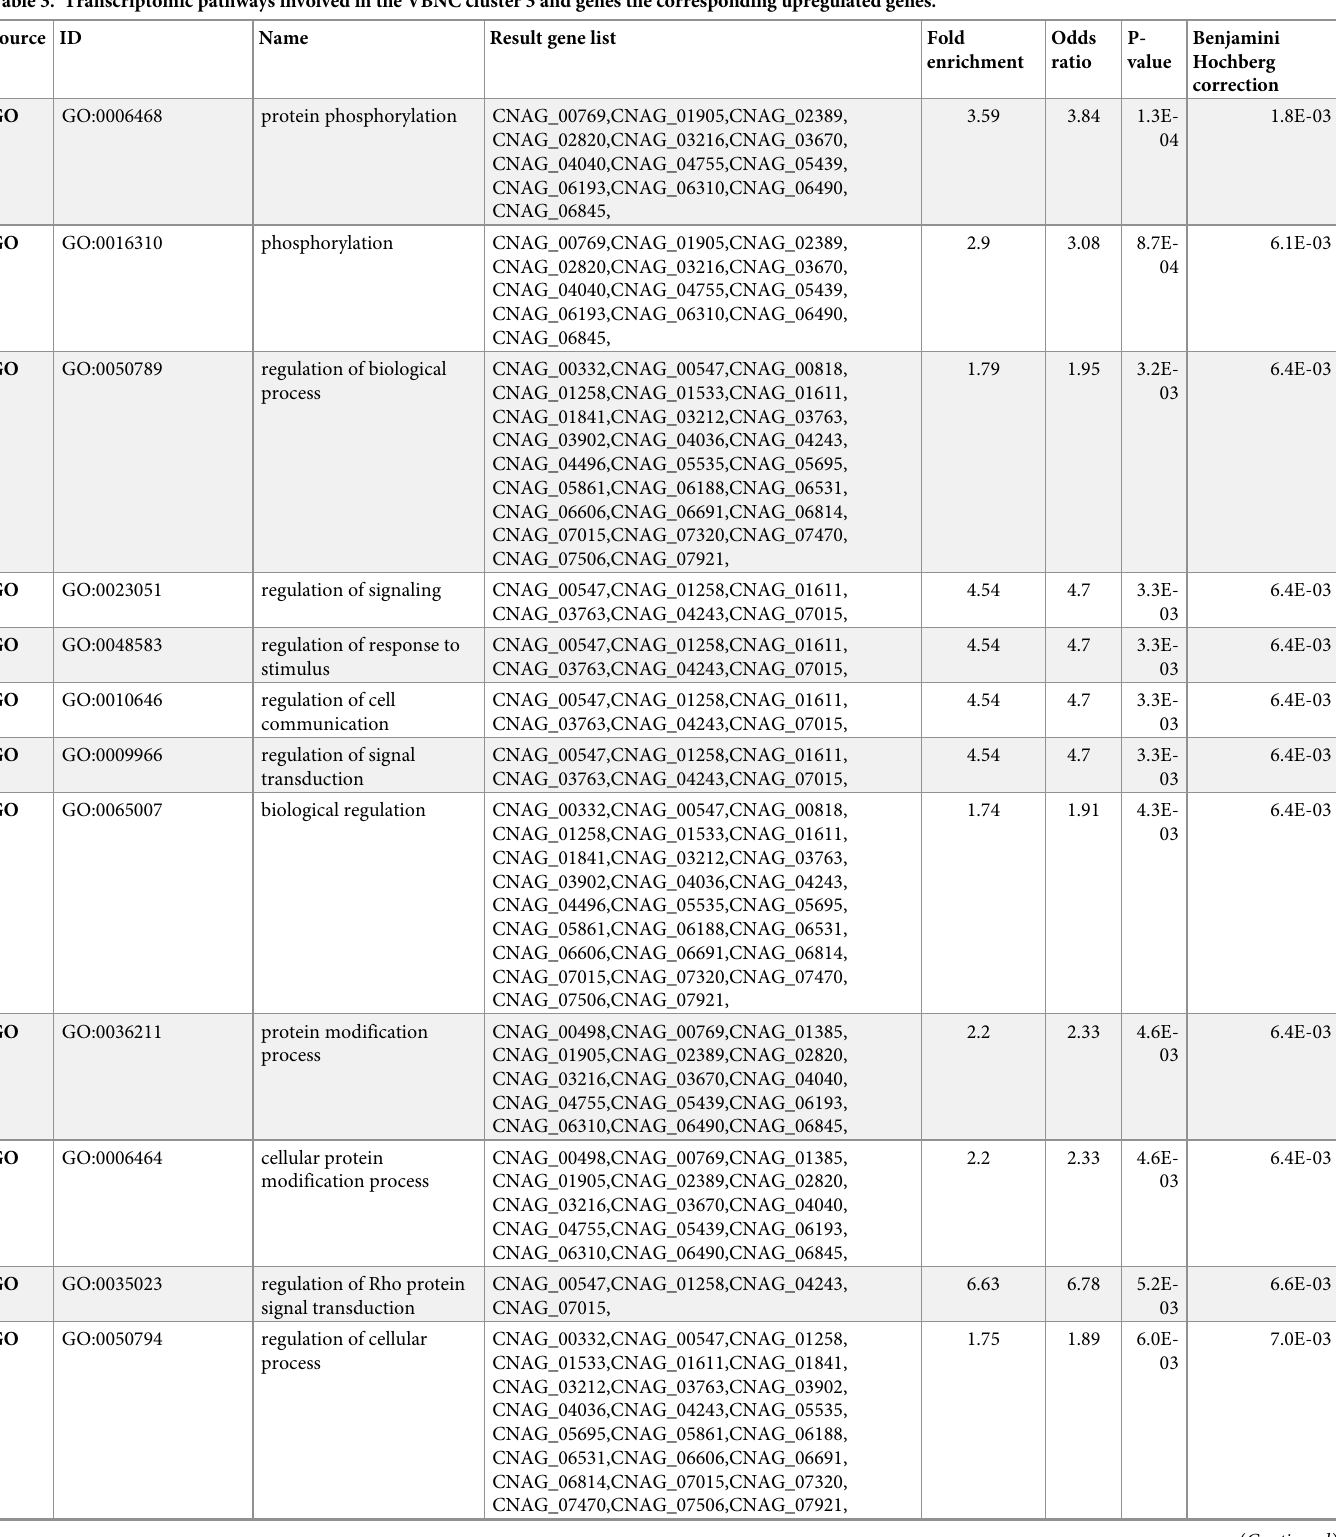
Table 3. Transcriptomic pathways involved in the VBNC cluster 3 and genes the corresponding upregulated